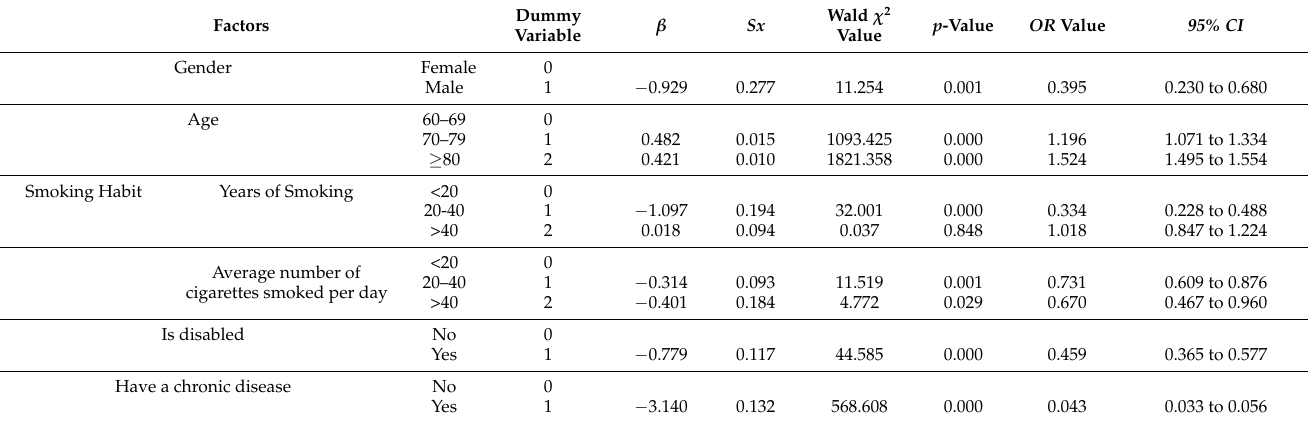
Table 3. Multi-factor binary logistic regression analysis of factors influencing ADL in older